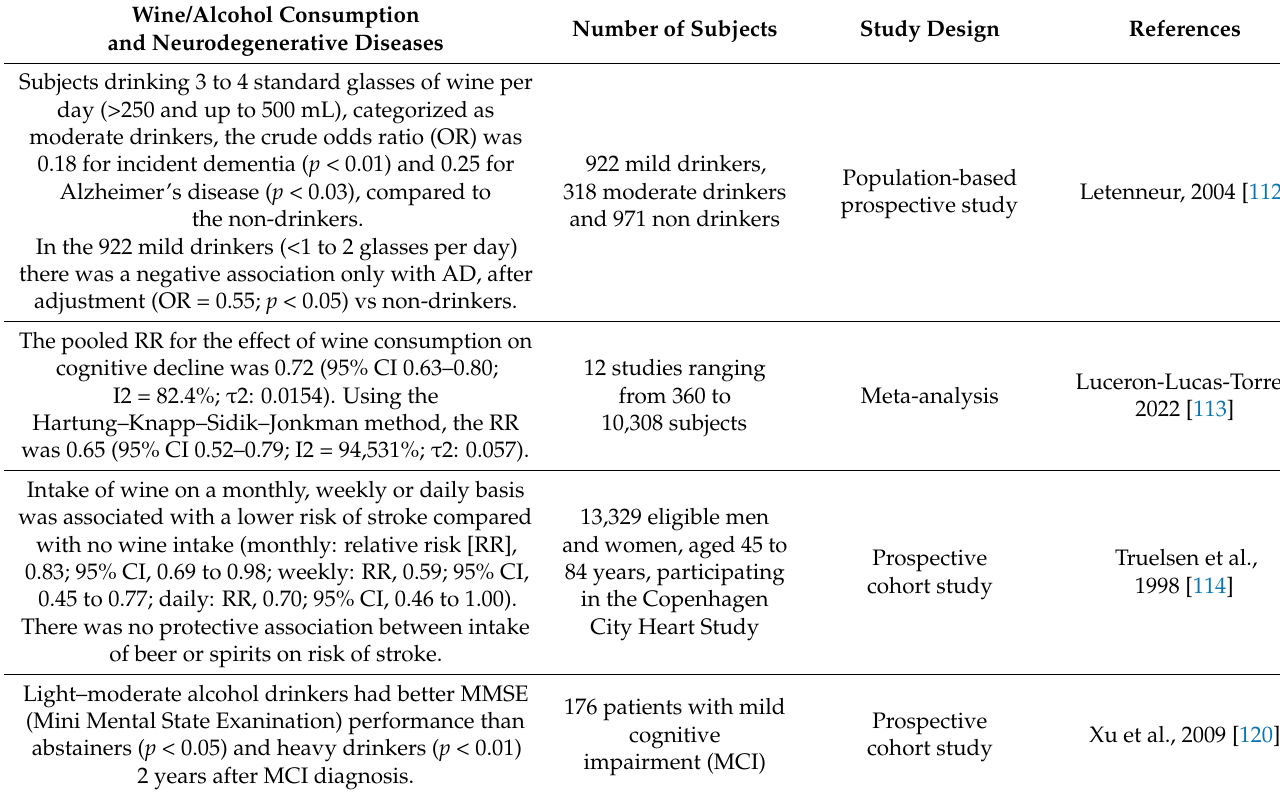
Table 3. Studies on wine consumption and risk of neurodegenerative